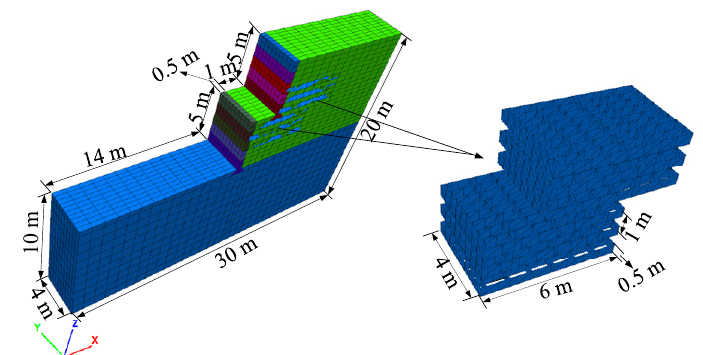
Figure 3. Model of reinforced retaining wall.